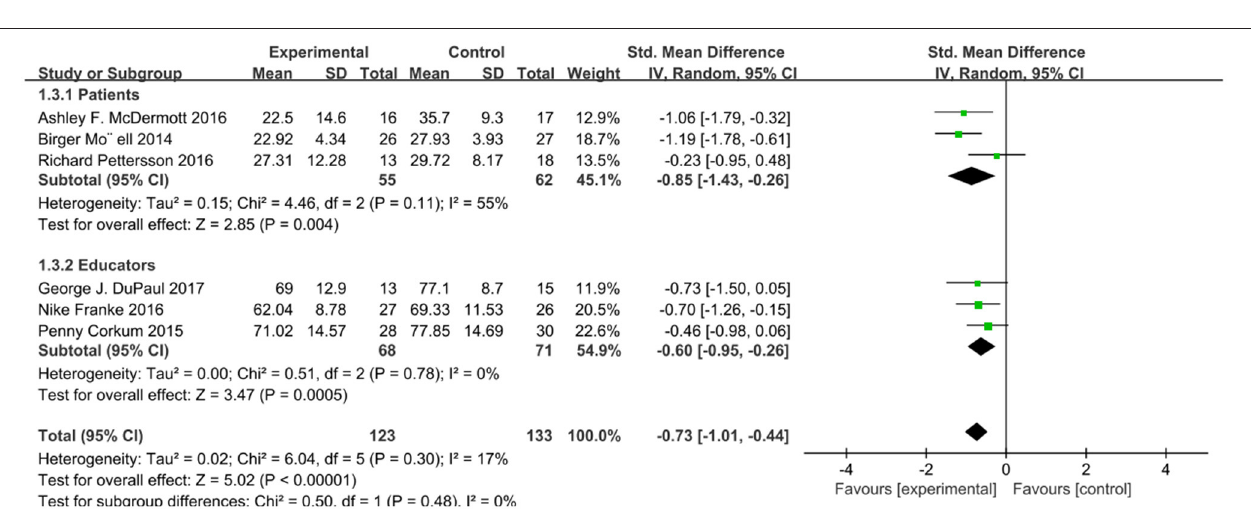
( P = 0.83), and social function score for children and adults I 2 = 65.8% ( P = 0.09). There was no heterogeneity in these four subgroup analyses ( Figures 4–7